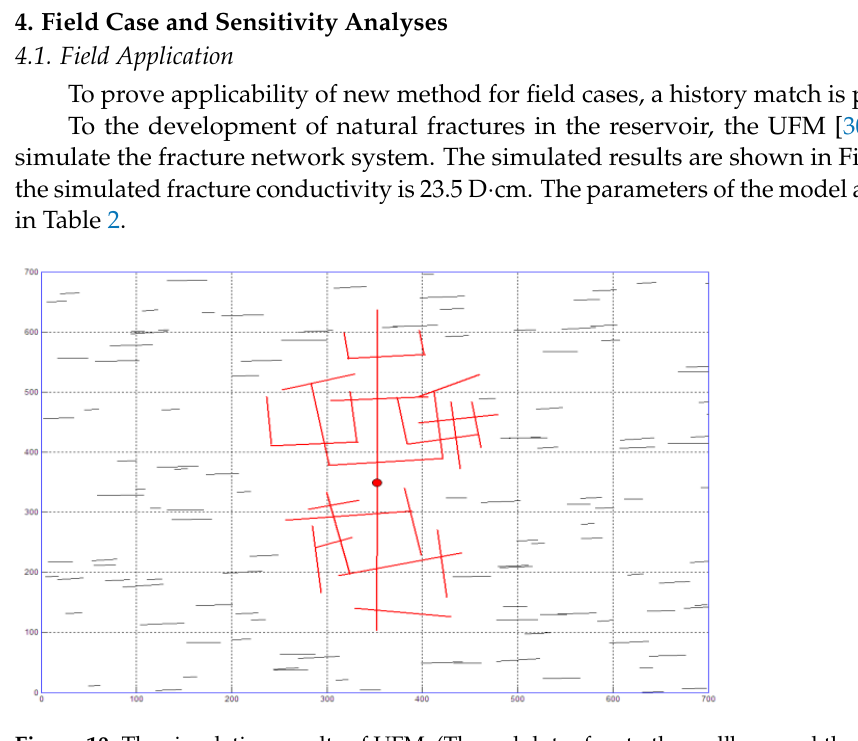
Table 2. Reservoir parameters of well A. Figure 9. T he workflow of the computational procedure. Figure 9. The workflow of the computational procedure.